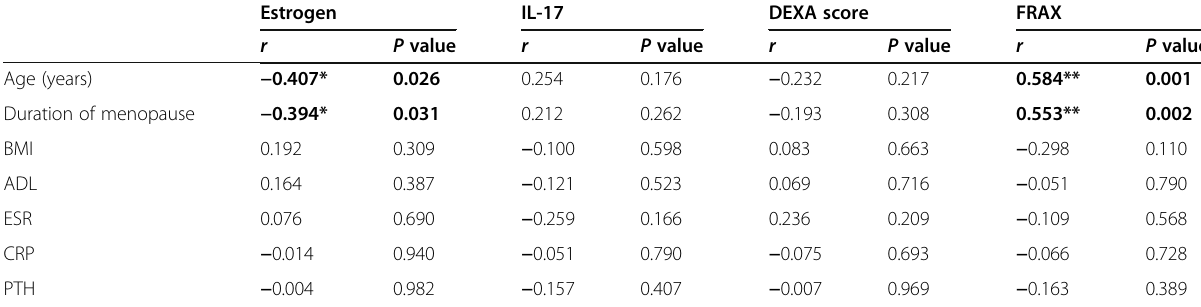
Table 4 Correlation study between IL-17, E2, radiological data, and different studied variables in postmenopausal women Estrogen